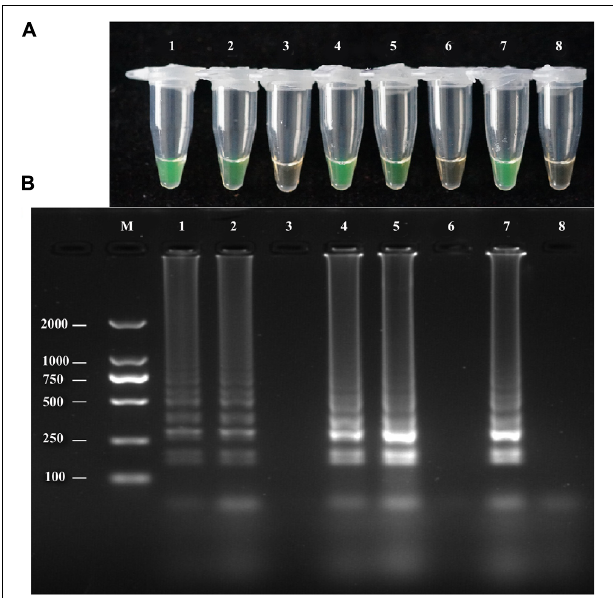
FIGURE 6 | LAMP detection of A. solani from infected potato field samples. (A) Visual inspection of LAMP assay using two different DNA extraction methods (rapid DNA extraction and CTAB DNA extraction) from potato plant tissues (leaf and stem). (B) Analysis of the LAMP products by 2% agarose gel electrophoresis. Lane 1: DNA extracted by rapid extraction from infected potato leaf; Lane 2: DNA extracted from infected stem by rapid DNA extraction; Lane 3: healthy plant tissue DNA extraction by rapid DNA extraction; Lane 4: DNA extracted from infected leaf by the CTAB method; Lane 5: DNA extracted from infected stem by the CTAB method; Lane 6: DNA extracted from healthy plant tissues by the CTAB method; Lane 7: positive control; Lane 8: negative control; Lane M: DL2000-bp DNA marker. Similar results were observed in three repeat